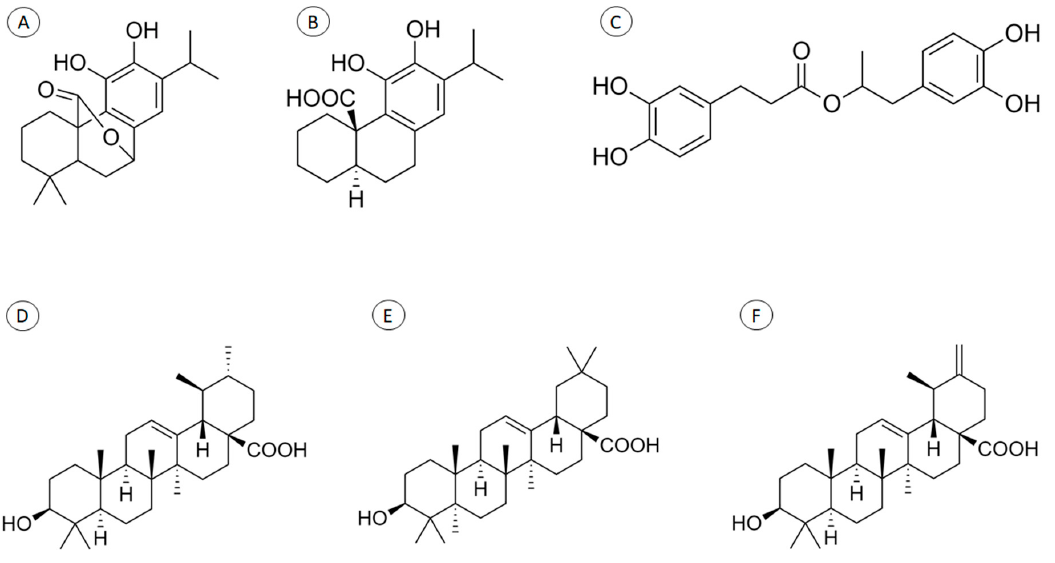
Figure 1. Chemical structure of some Rosmarinus o ffi cinalis secondary metabolites: carnosol ( A ), carnosic acid ( B ), rosmarinic acid ( C ), ursolic acid ( D ), oleanolic acid ( E ), and micromeric acid ( F ). Table 1. Results collected about Rosmarinus o ffi cinalis uses.